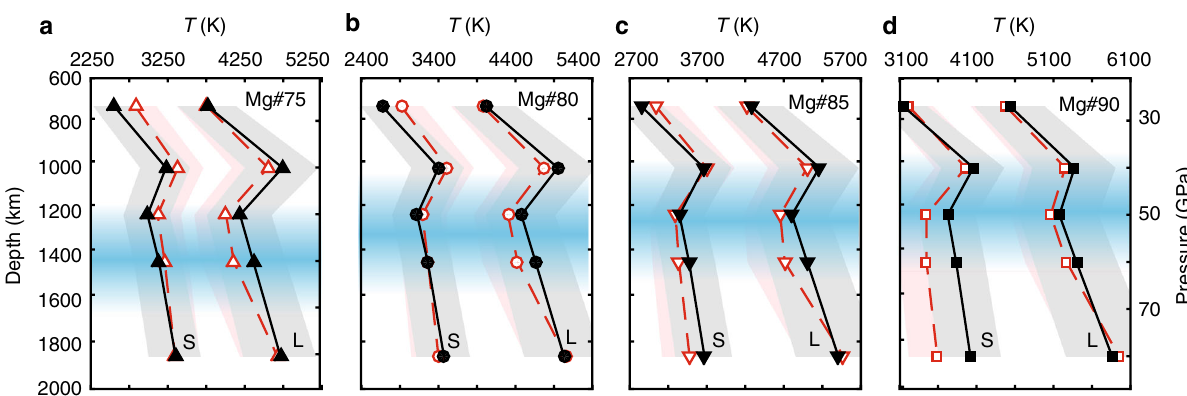
Fig. 3 Melting curves of ferropericlase. Liquidus (L) and solidus (S) temperatures of a (Mg 0.75 Fe 0.25 )O (triangles), b (Mg 0.8 Fe 0.2 )O (circles), c (Mg 0.85 Fe 0.15 )O (inverted triangles), and d (Mg 0.9 Fe 0.1 )O (squares) assuming the ideal (red, open symbols) and regular solution models (black, solid symbols), respectively. Uncertainties (95% con fi dence interval) on the temperatures are ~ ± 10% as indicated by the red and gray shaded regions for the ideal and regular solution models, respectively. The blue shaded regions correspond to the composition-dependent spin transition pressure range at 300 K (~35 – 70 GPa) 33 . The spin transition pressure ranges at corresponding high temperatures are likely broader but begin at pressures similar to those at 300 K 65,66 . The curves are drawn as a guide for the